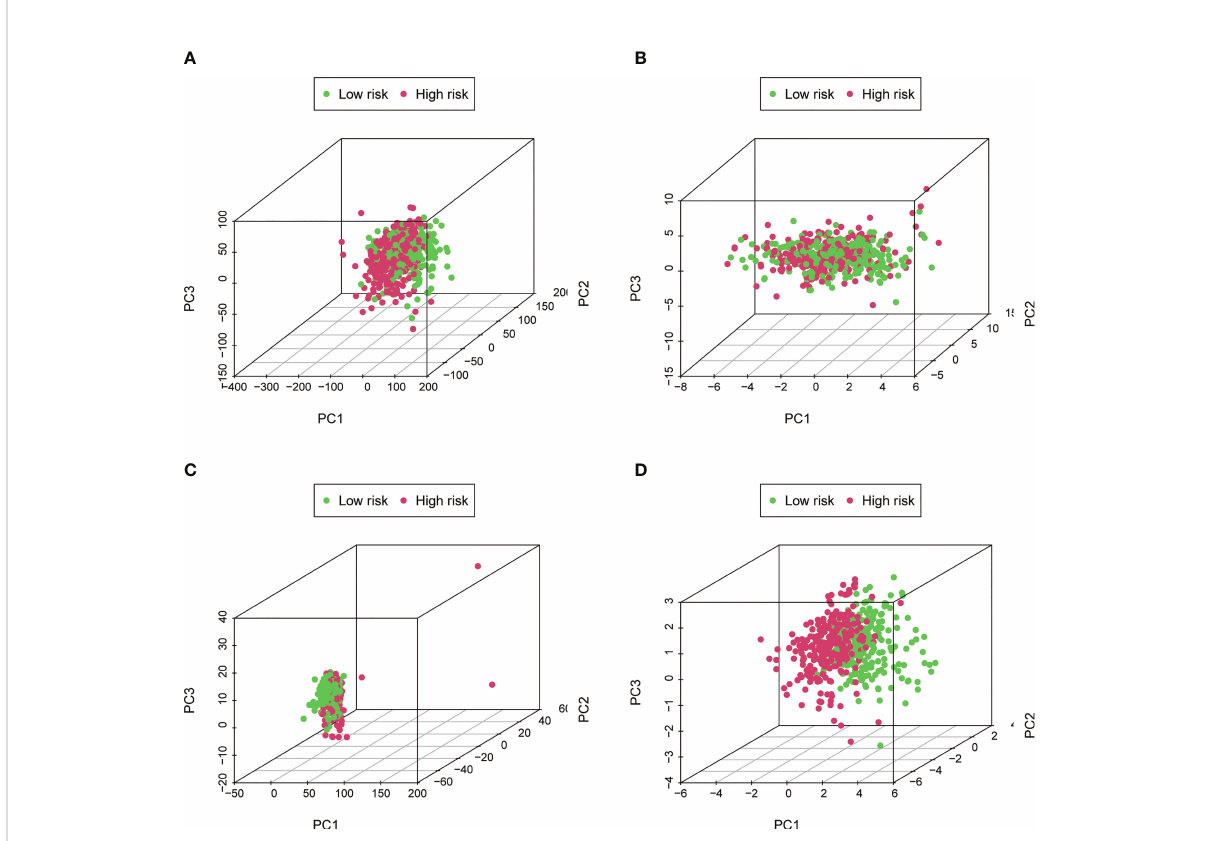
(Figure 8H), AC022144.1 was correlated with grade and fustat (Figures 8I, J), and BOLA3-AS1 was associated with grade, stage, and fustat (Figures 8K –